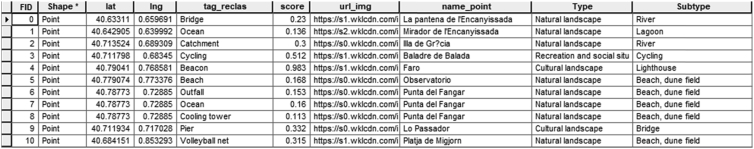
Screengrab of the dataset.